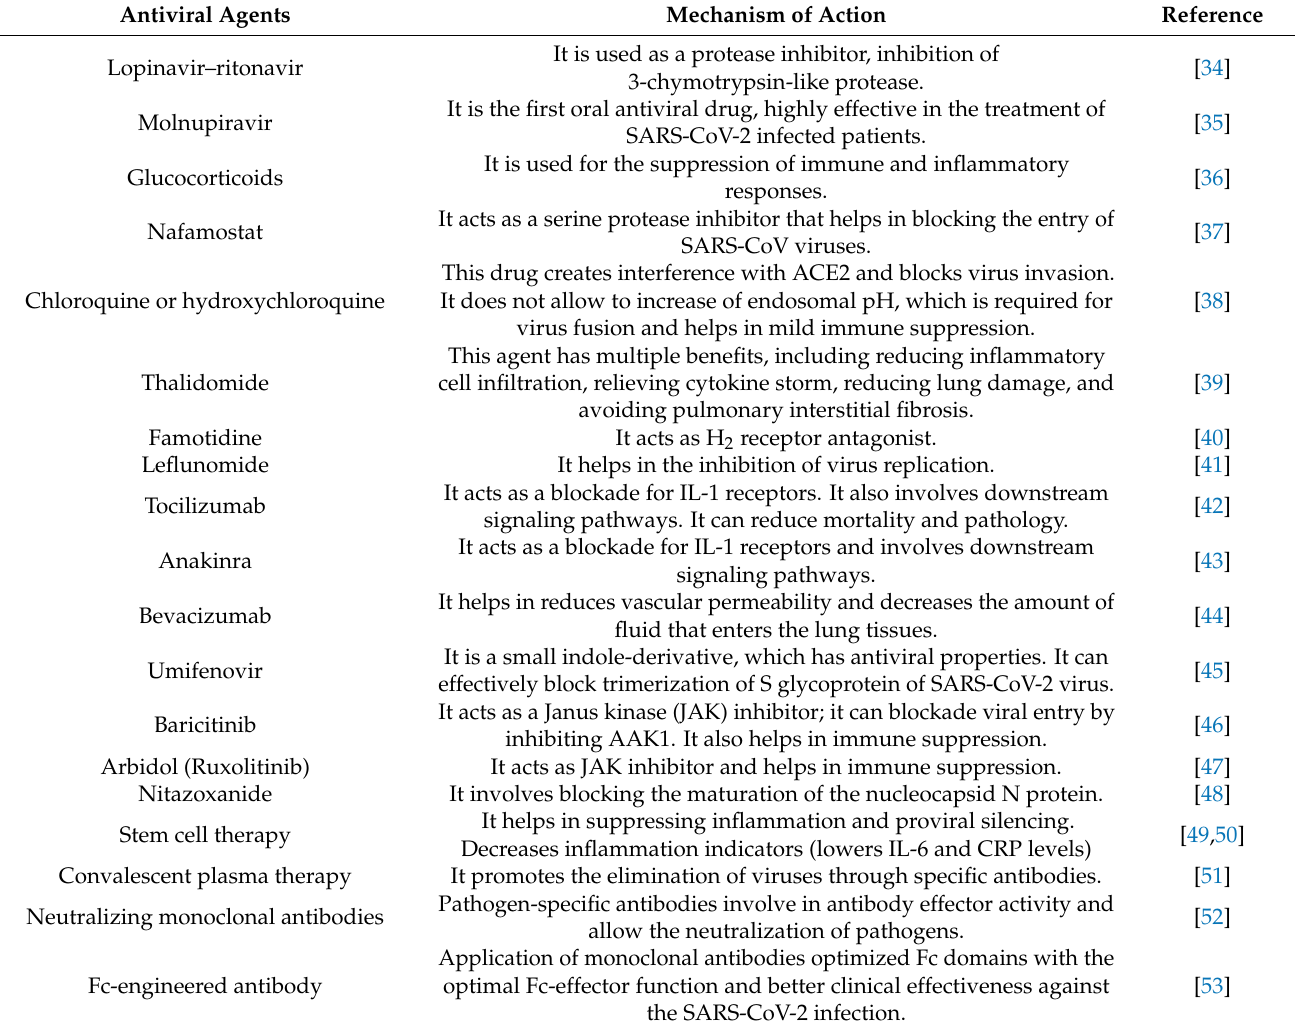
Table 1. Mechanism of types of drugs and therapies useful in the treatment of SARS-CoV-2-infected patients